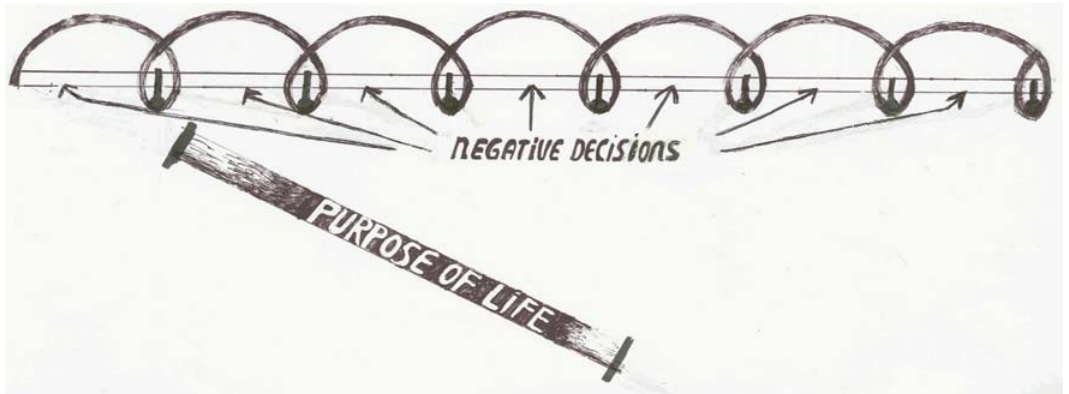
FIGURE 3 . Low quality of life; poor health and poor functional ability in relation to social life, work life, and sexuality are derived from locking up your existence with negative decisions. The condition is rigid and undynamic and can be illustrated by a stretched spring that lost its ability to dance and vibrate